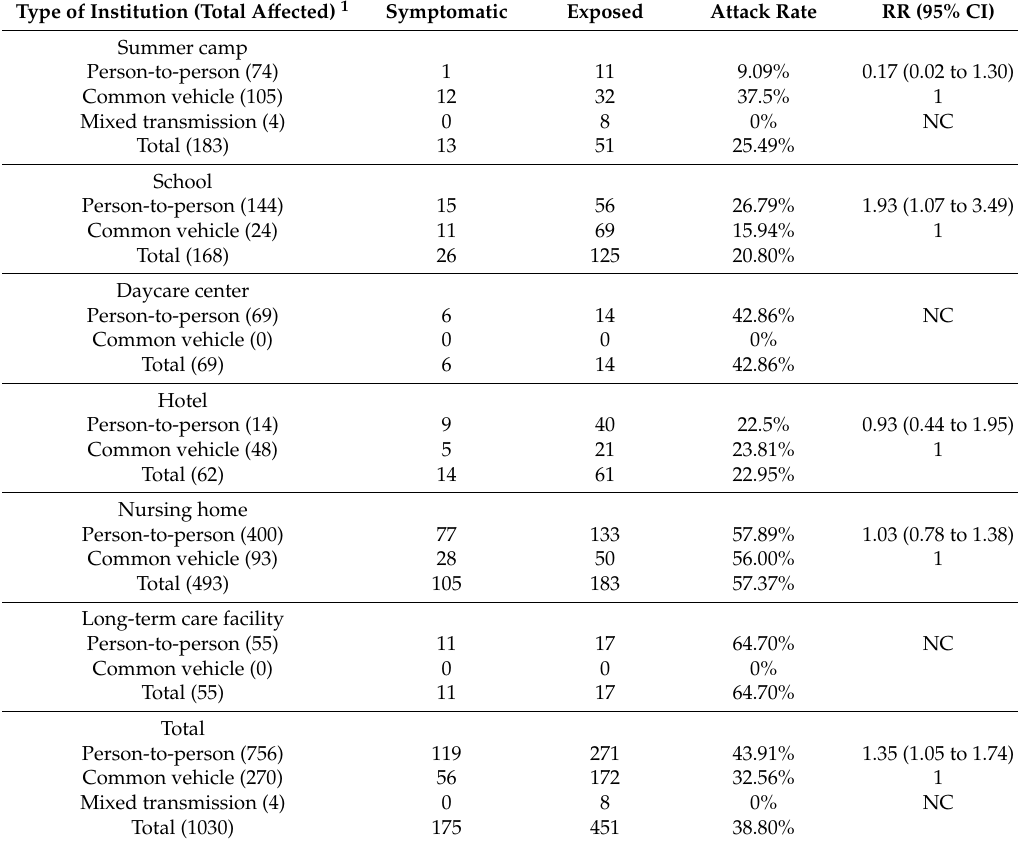
Table 2. Attack rates and rate ratios (RRs) in workers according to type of institution and type of transmission.